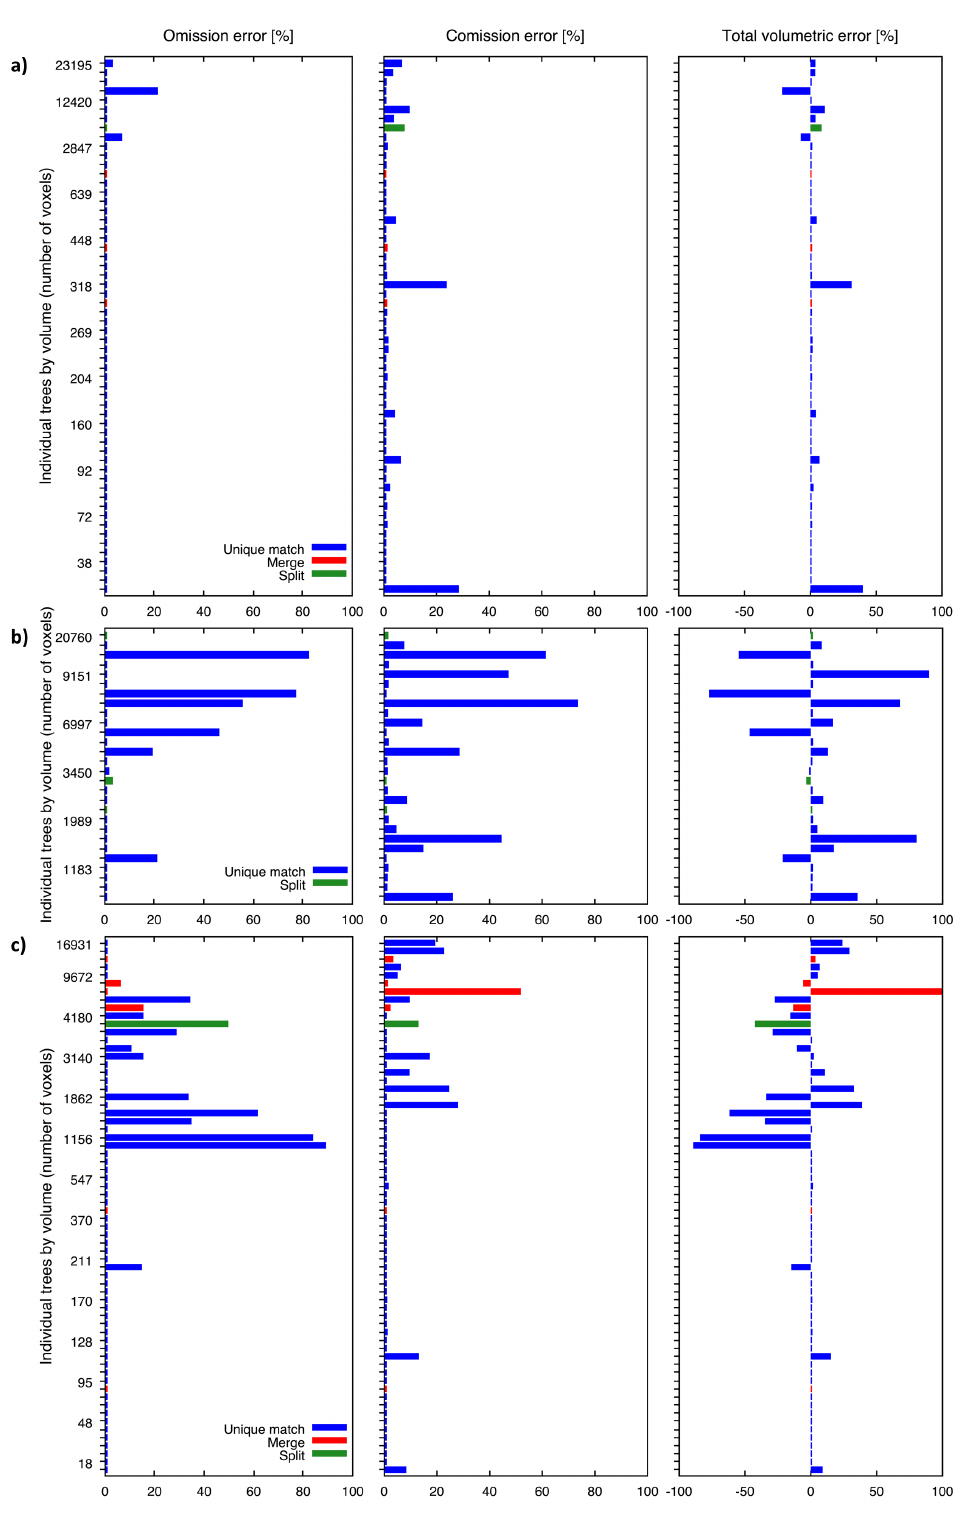
Figure 4. Error metrics referring to the intersection and volumetric match between the detected tree clusters and the manually digitized 3D references. ( a – c ) show the results for the first quadrants of plots one, four and five, respectively. For each plot, the omission, commission and the total volumetric error are given as percentage on the x -axes. The volume is indicated as number of voxels for the individual trees on the y -axes and sorted in decreasing order. Additionally, merge and split errors are indicated by the colour of the error